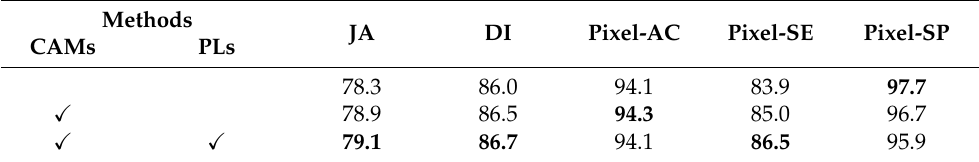
Table 5. Segmentation performance of the CL-DCNN model on the ISIC 2017 testing set after training with CAMs and pseudo-labels. The highest results are shown in bold font for easy observation and